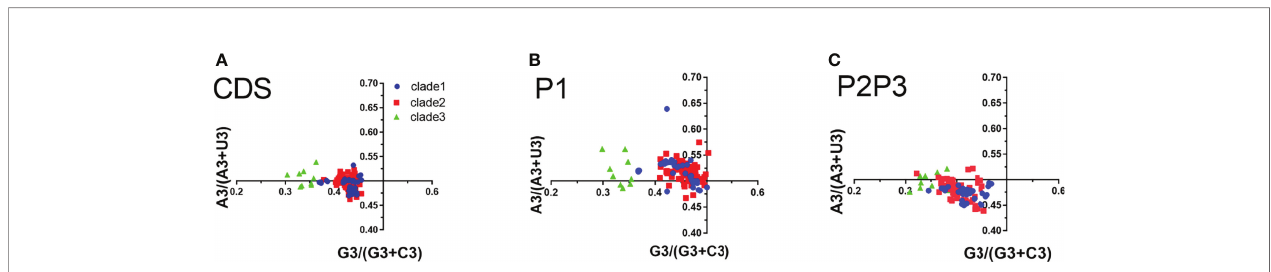
FIGURE 5 | Parity rule 2 (PR2) bias plots. PR2 plots were constructed for the coding sequences, P1 and P2P3 regions of EV-A strains respectively. (A) coding sequences, (B) P1 region, (C) P2P3 region. The blue dots, red squares, and green triangles indicate clade 1, clade 2 and clade 3 strains.